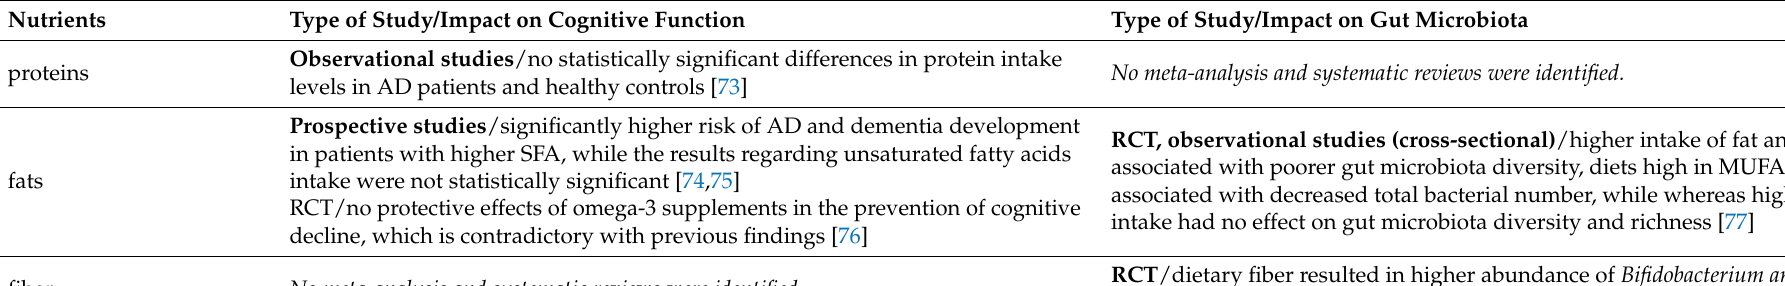
Table 4. Summary of the evidence (from meta-analysis and systematic reviews) deriving from human studies aimed at evaluating the impact of nutrients on cognitive function or gut